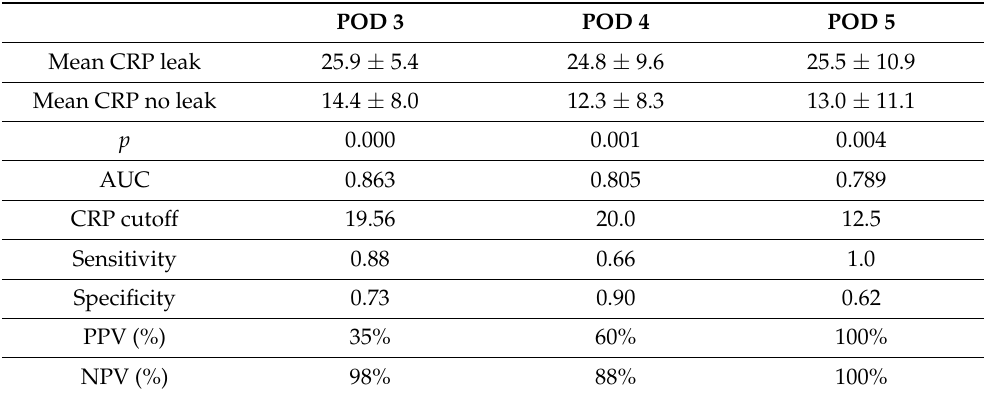
Table 3. Postoperative